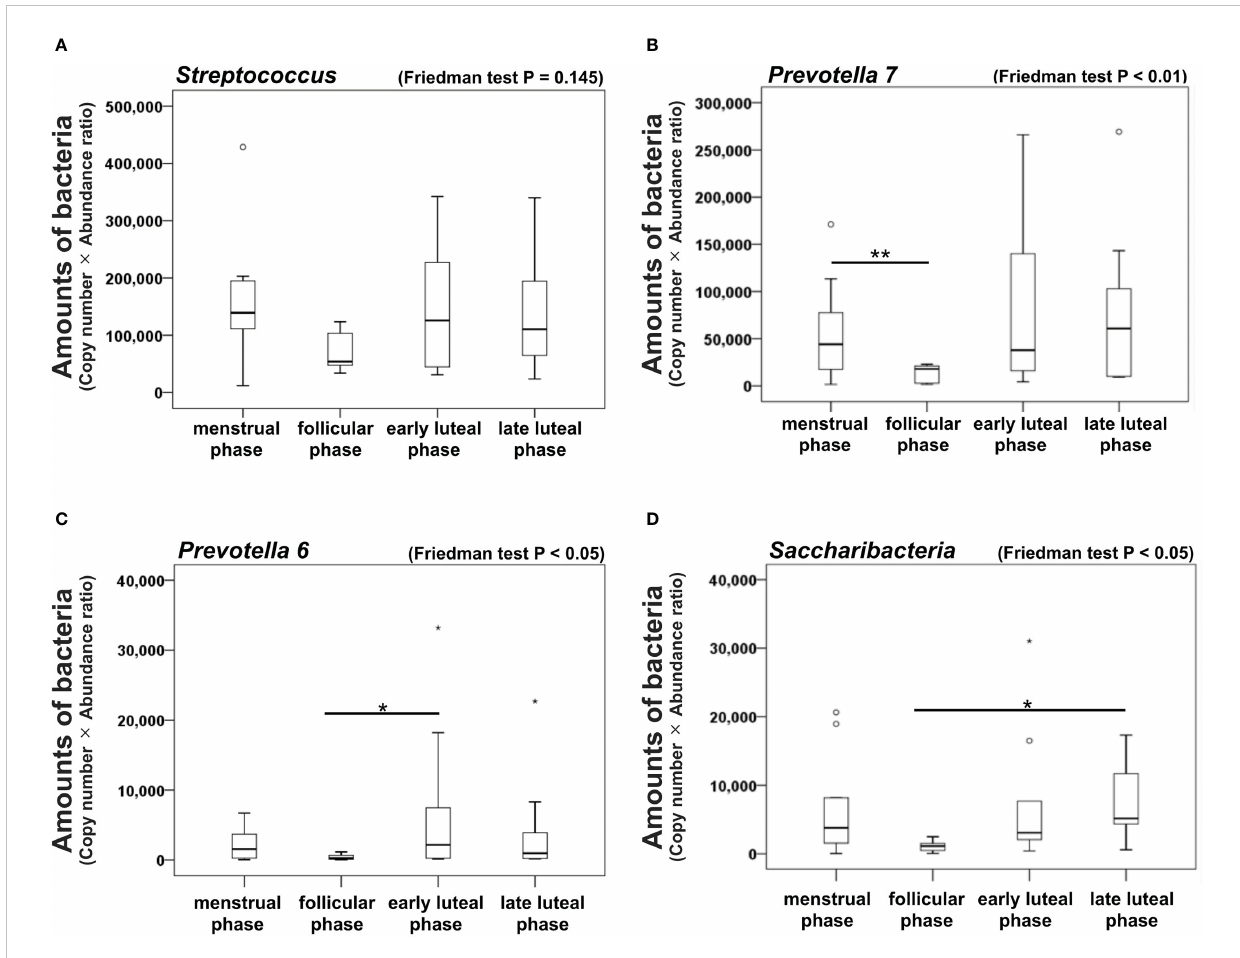
FIGURE 5 Amounts of dominant bacteria genera in the oral microbiome of female subjects. Box plots showing the amounts of (A) Streptococcus , (B) Prevotella 7 genera, (C) Prevotella 6 , and (D) Saccharibacteria genera during the menstrual cycles. Friedman test and Bonferroni test, * P < 0.05 and ** P < 0.01. N = 9.